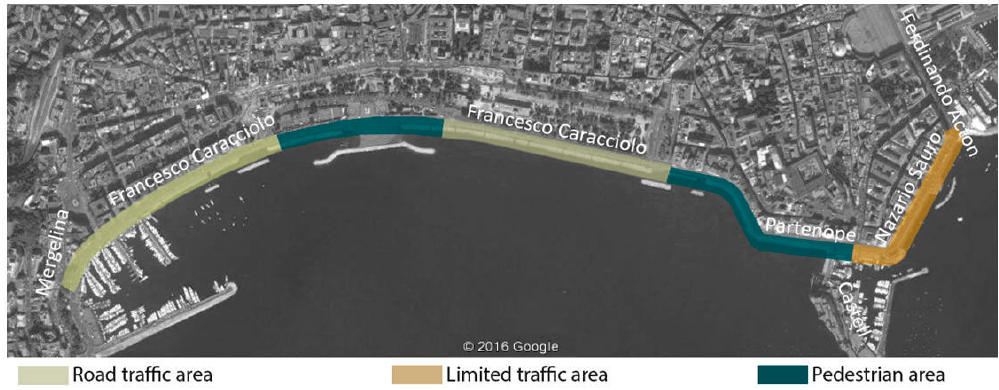
Figure 1. Stretch of the waterfront under investigation (base aerial photograph © 2016 Google).